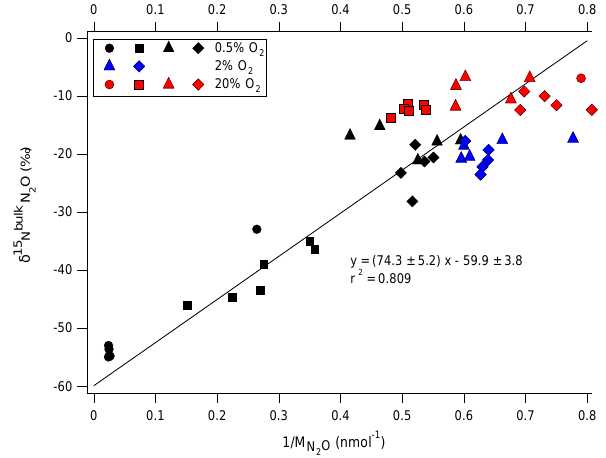
Fig. 4. Pathway dependence of δ 15 N bulk N 2 O. Symbol shapes cor- respond to different starting cell densities: circles correspond to 1.5 × 10 6 cells ml − 1 , squares to 2 × 10 5 cells ml − 1 , triangles to Fig. 3a. N 2 O yields in the presence and absence of nitrite-oxidizing 2 . 1 × 10 4 cells ml − 1 , and diamonds to 2 × 10 2 cells ml − 1 . Colors bacteria (NOB). Starting NH + concentrations were 50µM. 4 Fig. 3b. N 2 O yields in the presence and absence of nitrite-oxidizing bacteria (NOB). Starting NH + 4 concentra- correspond to headspace O 2 levels, with black symbols represent- tions were 50 µ M. ing 0.5% O 2 , blue symbols 2% O 2 , and red symbols 20% O 2 . The slope and intercept of a Type II linear regression of δ 15 N bulk and 1 / M N are given ± one standard deviation. In making a linear 2 O fit to the data, we assume that any differences in total N 2 O are due to nitrifier-denitrification. The y-intercept of the line is equal to the δ 15 N bulk of N 2 O from nitrifier-denitrification. Data points that were less than 1nmol N 2 O were not